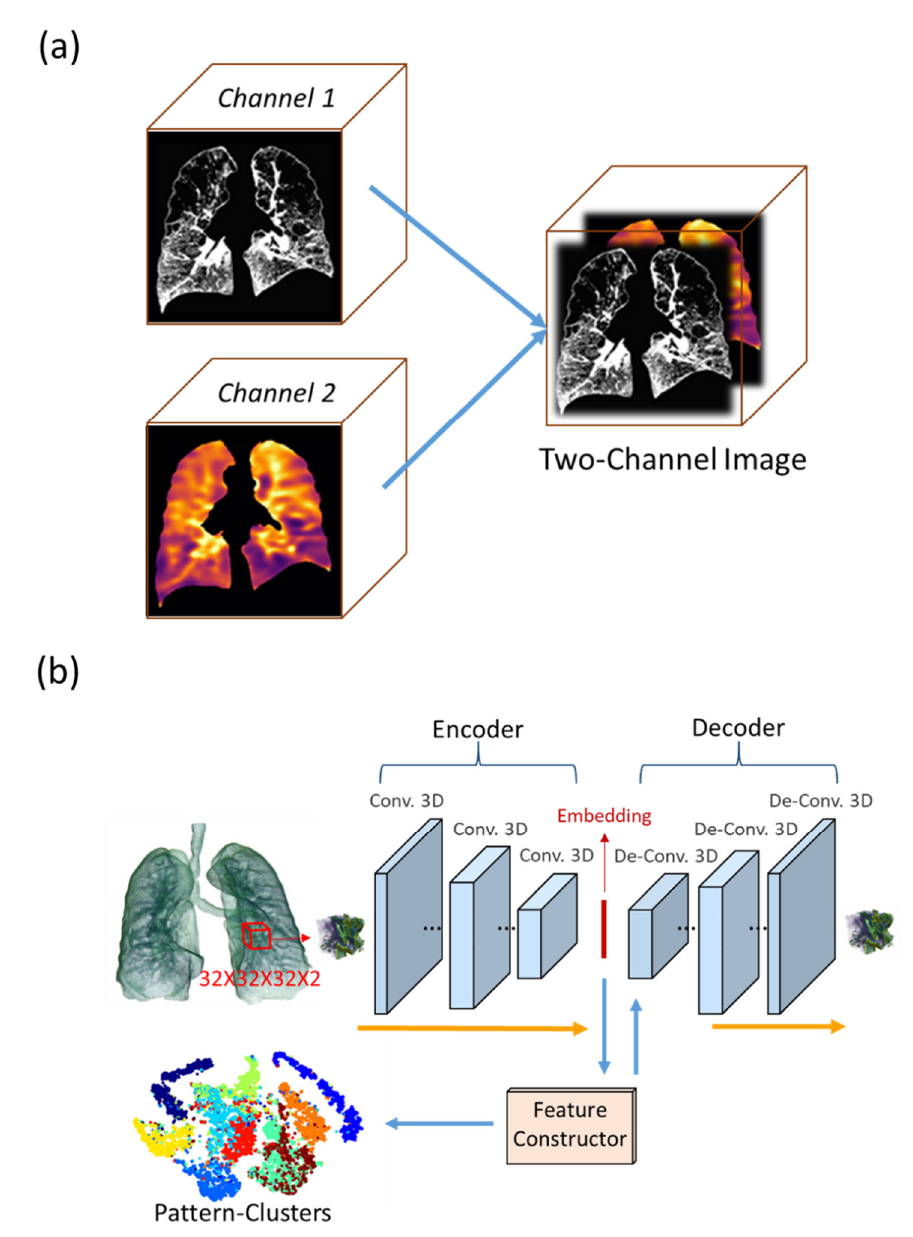
Figure 1. ( a ) A two-channeled image was constructed using the IN image as the first channel and the Jacobian mask as the second channel. ( b ) Schematic of the CAE-FC model. Reprinted/adapted with permission from Ref. [13], 2021, Li et al. The ROIs were fed into the 3D CAE-FC model to obtain their one-dimensional (1D) representations and to group the ROIs with similar patterns into pattern clusters.